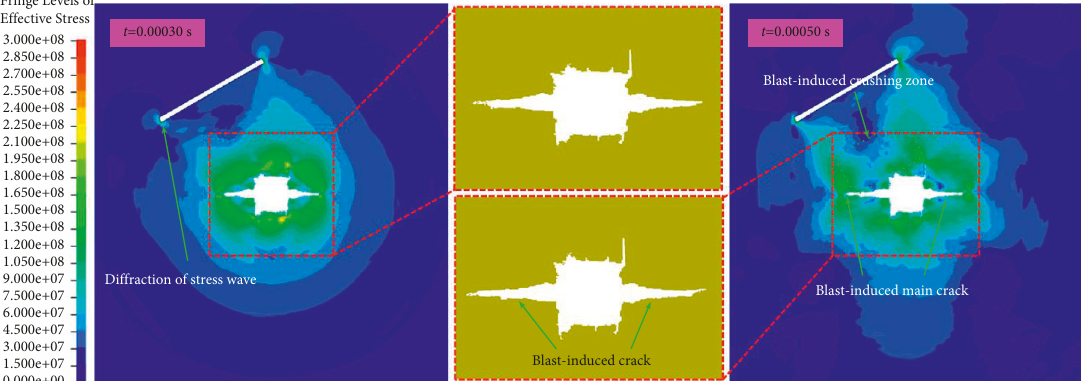
Figure 7: Pressure diagram of explosion stress wave transmission for case CN